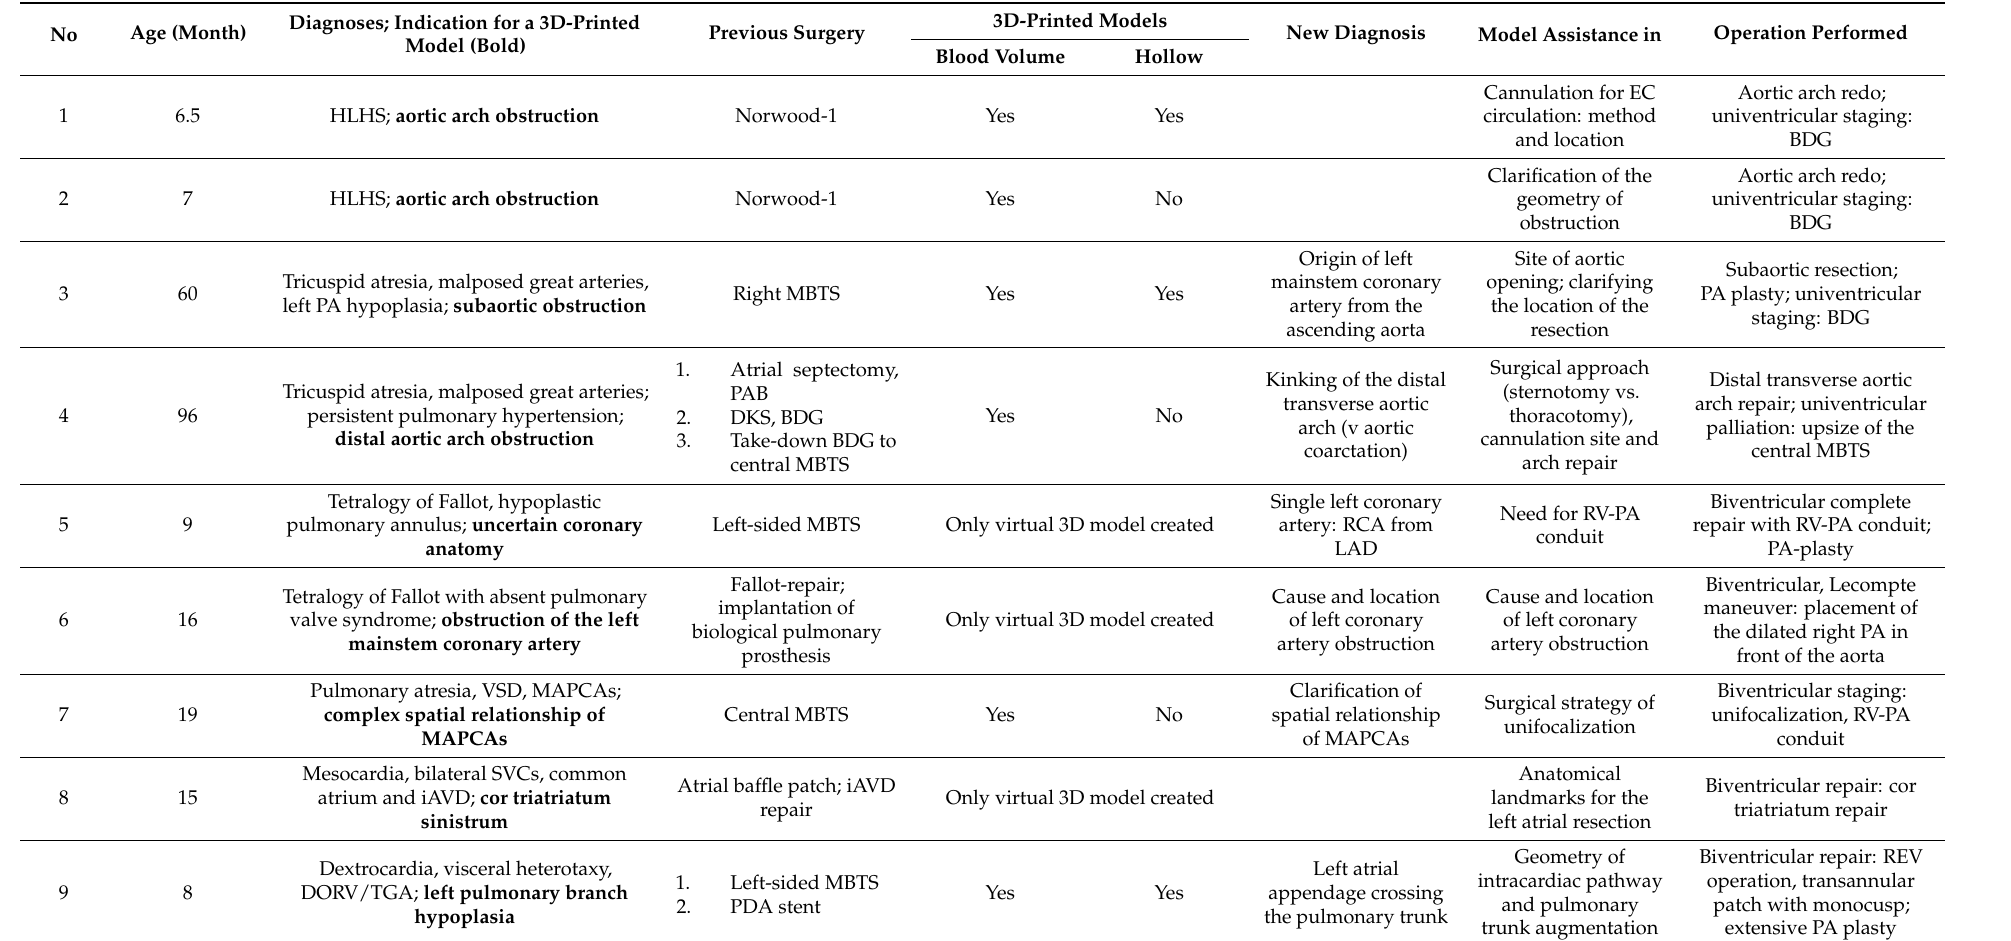
Table 2. Characteristics of congenital heart patients undergoing surgery using 3D-printed